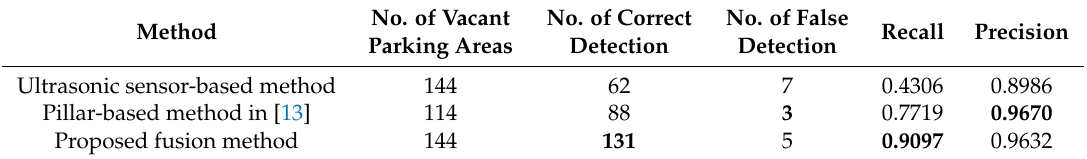
Table 3. Performance comparison of parking area detection methods in GD.